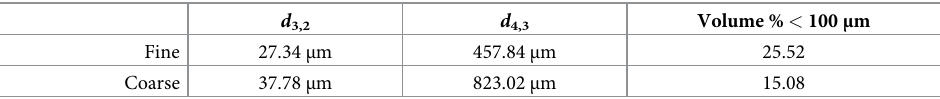
Table 1. Fine and coarse grind particle size distribution